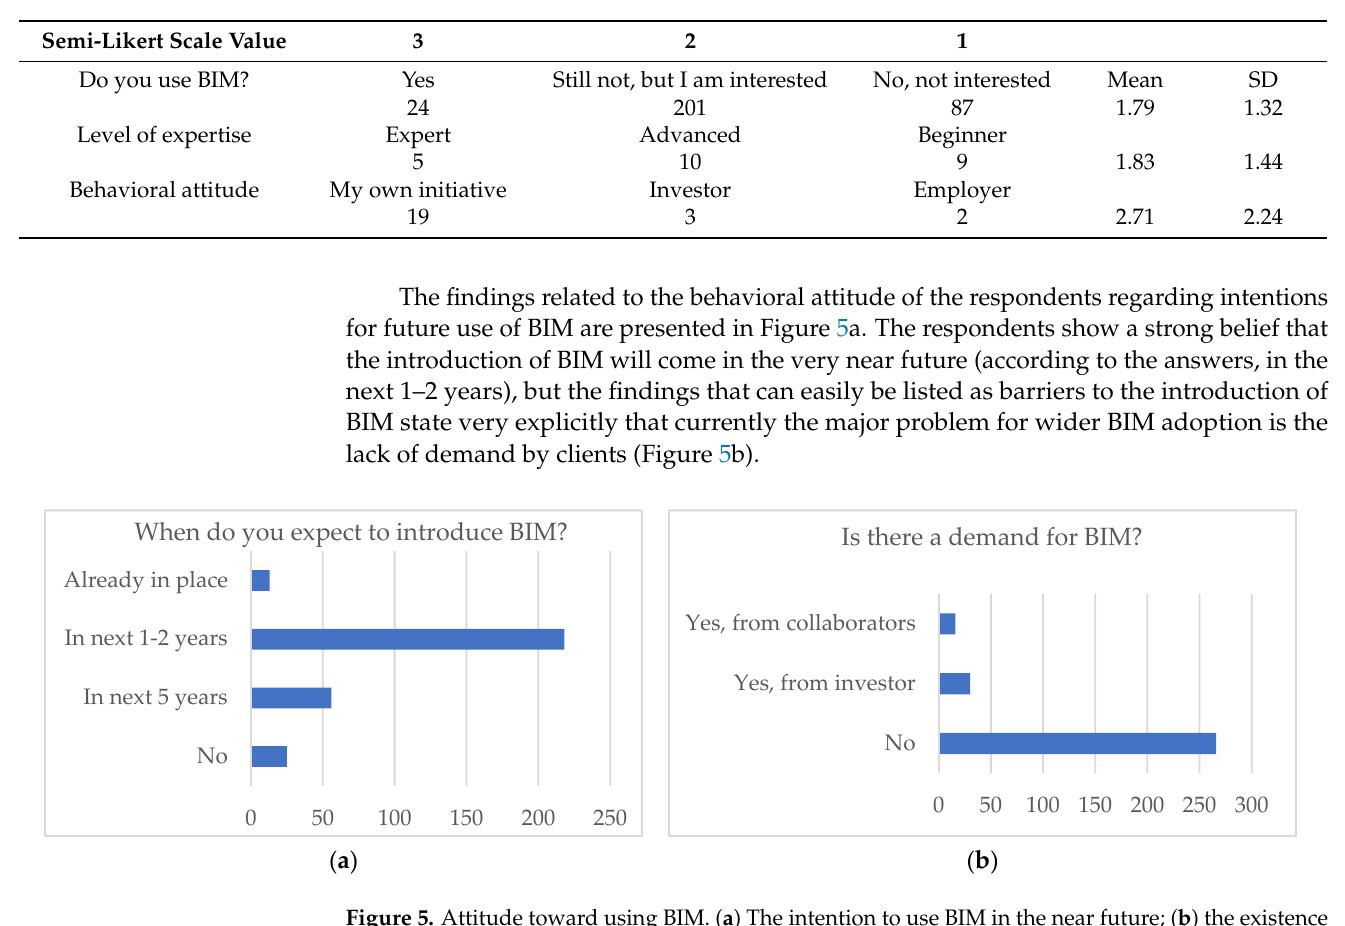
Table 4. Statistics for the level of usage of BIM measured by a semi-Likert scale.